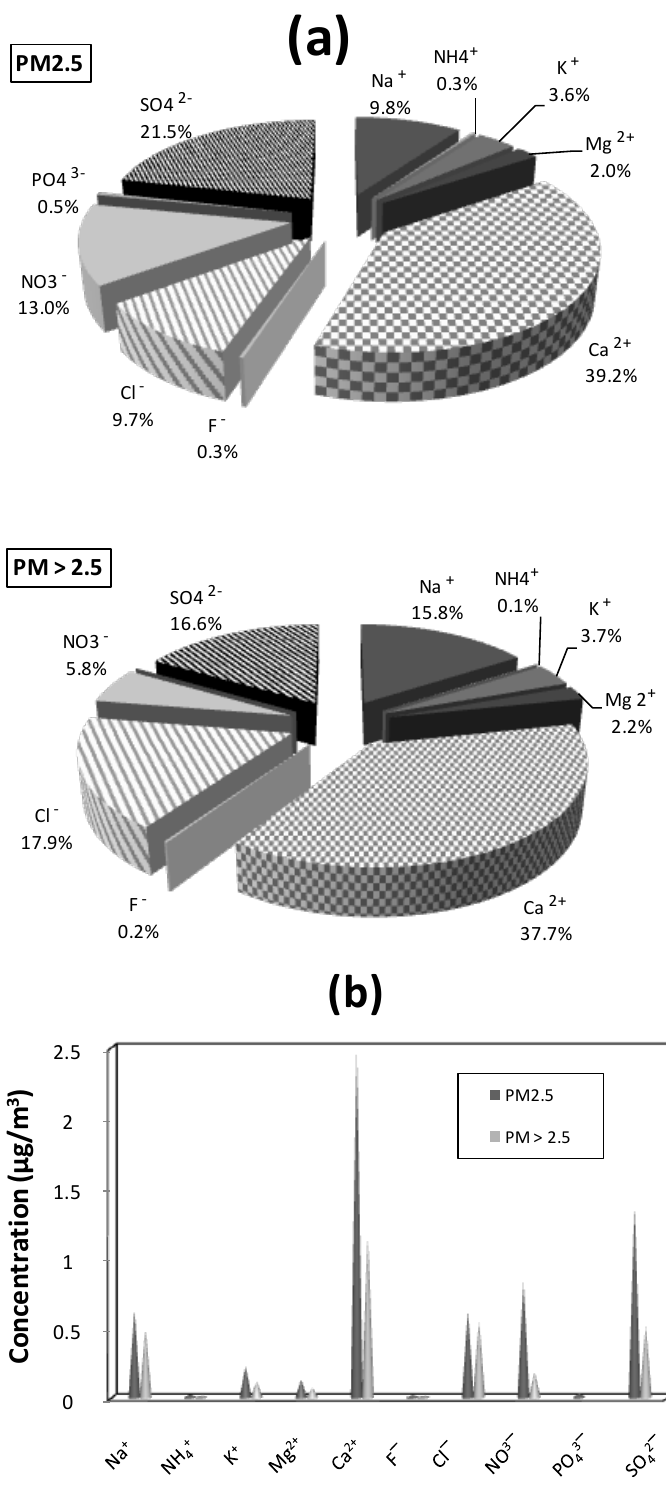
Figure 3. Proportion in % ( a ) and concentrations in µg/m 3 ( b ) of water-soluble ions in the PM 2.5 and PM >2.5 samples collected in an urban area of Cotonou (Benin).